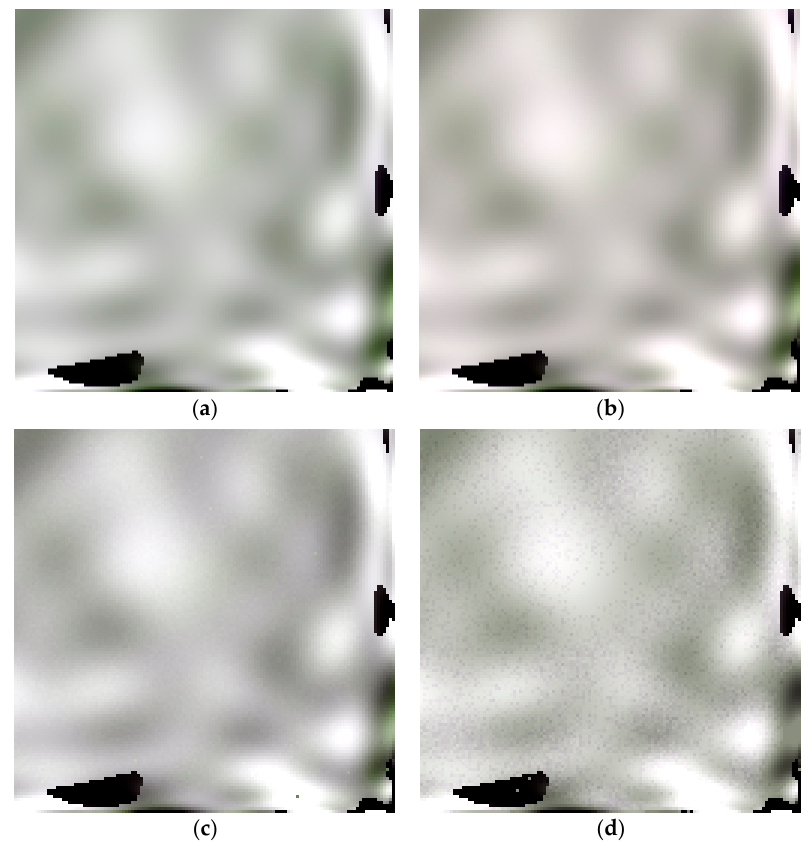
Figure 13. Reconstructed images. ( a ) DSPP+VCA; ( b ) SPP+VCA; ( c ) RBSPP+VCA; ( d ) SSPP+VCA.